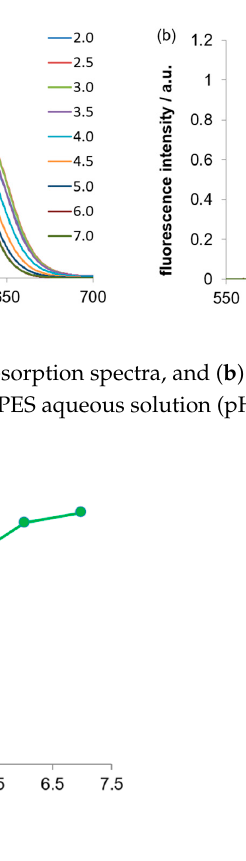
Figure 2. Absorption (blue line) and fluorescence (red line) spectra ( λ ex = 621 nm) of BRhoC (8.7 μ M) in a 10 mM HEPES buffer at pH 7.4.